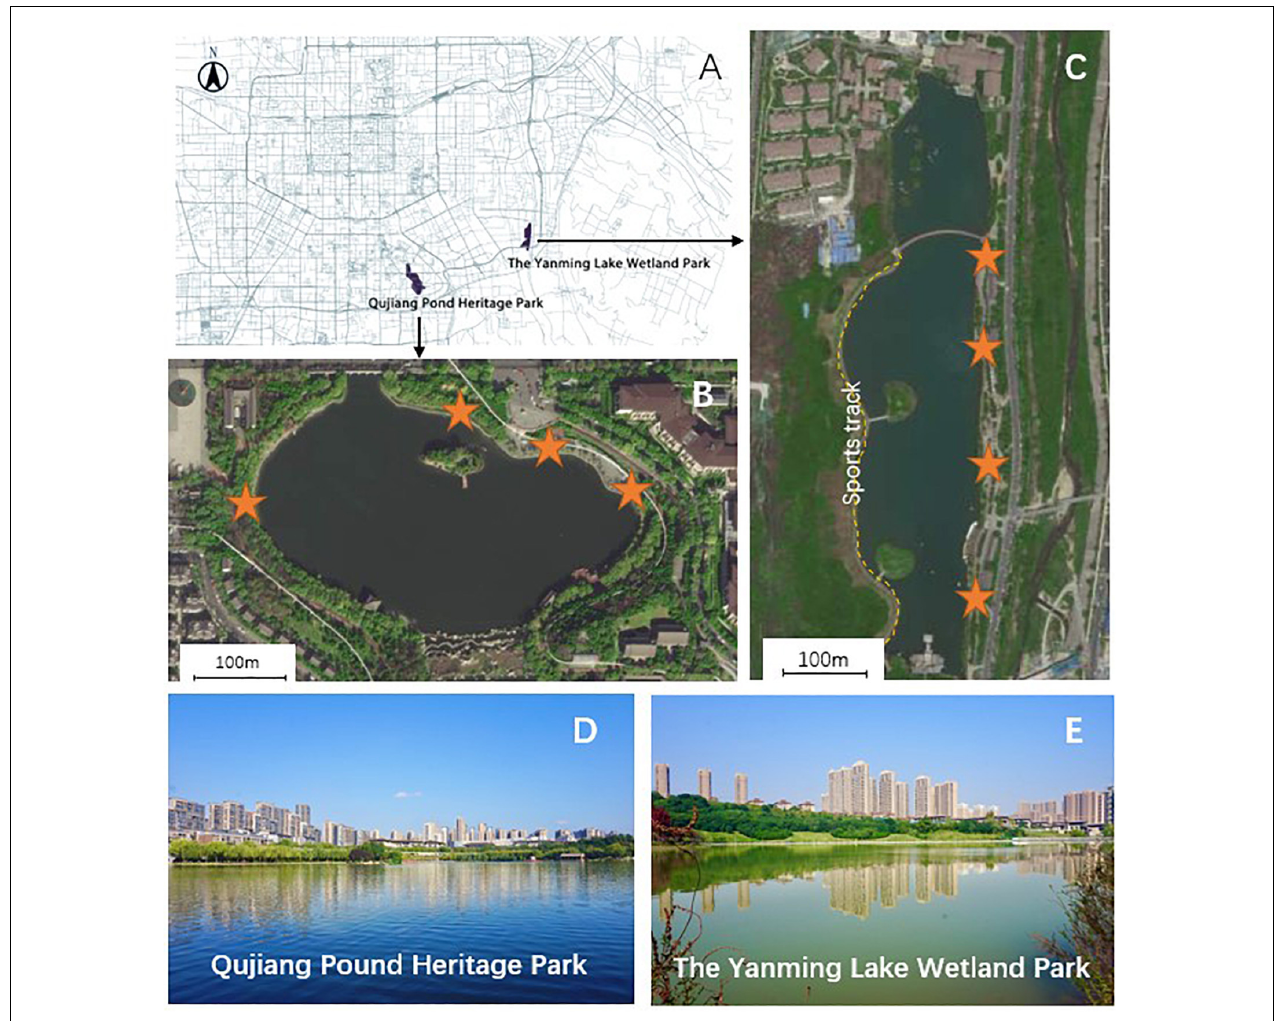
FIGURE 1 | Study area and photographs: (A) Location of the Qujiang pond heritage park and the Yanming lake wetland park in Xi’an, China; (B) four sample points in the Qujiang pond heritage park; (C) four sample points in the Yanming lake wetland park; (D,E) two images of the two study